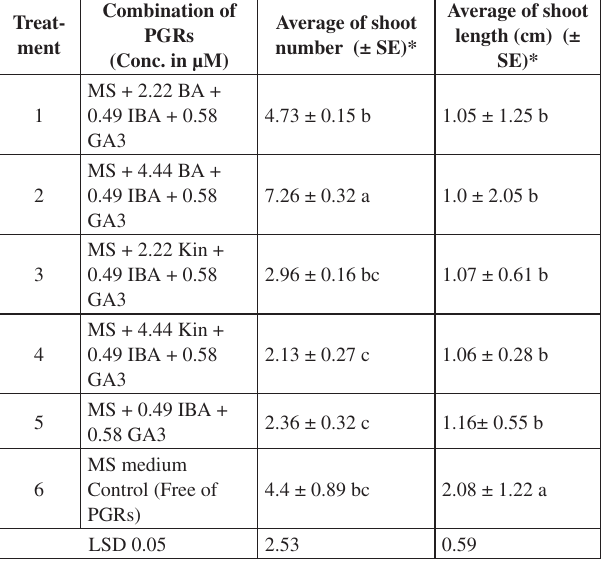
Table 1 Effect of PGRs combinations on number and length of shoots produced in vit ro in A. halimus L. within 4 weeks of culture Combination of Treat- PGRs ment